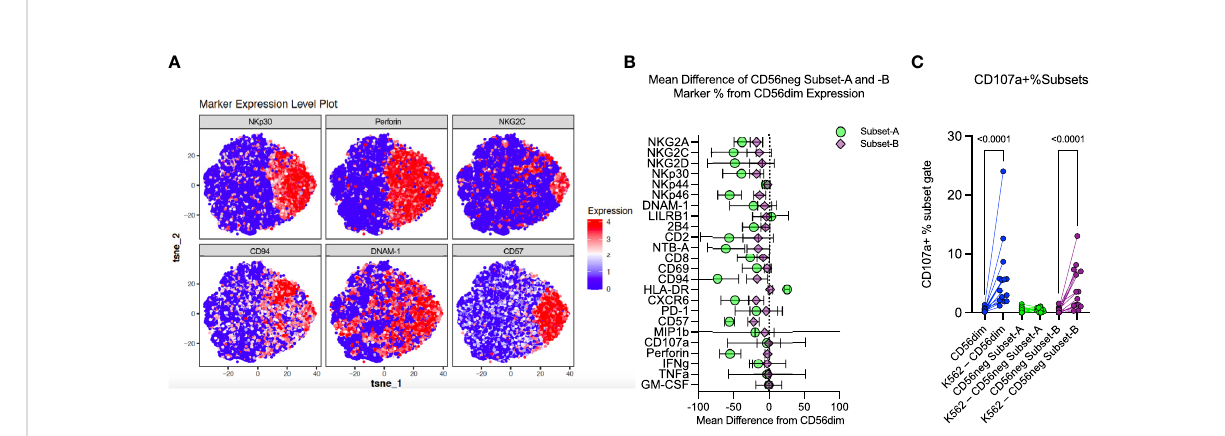
FIGURE 4 CD56neg cell analysis indicates distinct subset presence. (A) these tSNE plots were generated from exported CD56neg cells from the SDY517 dataset using the R cytofkit package, and show the main markers found to be signi fi cantly different in the Bozzano study that identi fi ed two subsets within the CD56neg NK cell population (32). Two subsets could be similarly de fi ned through predominantly the expression of perforin, as well as surface expression of CD94 and other markers, to identify perforin - CD94 - NKG2C - NKp30 - CD57 - DNAM-1 - (Subset-A) cells, and all other CD56neg NK cells (Subset-B). (B) this plot shows the combined mean difference of Subset-A and -B CD56neg cell frequency marker expression from CD56dim NK cells from the datasets SDY517, SDY1535, and FR-FCM-ZYZ3. (C) this graph shows the change in CD107a + CD56dim, Subset-A and -B CD56neg NK cell frequencies, comparing unstimulated expression to K562 stimulated levels